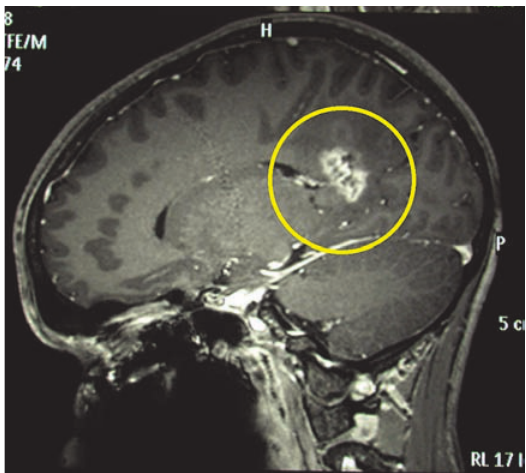
Figure 7 Radionecrosis follow- ing radiosurgery for an AVM shown on a T1-MRi with gadolin- ium.